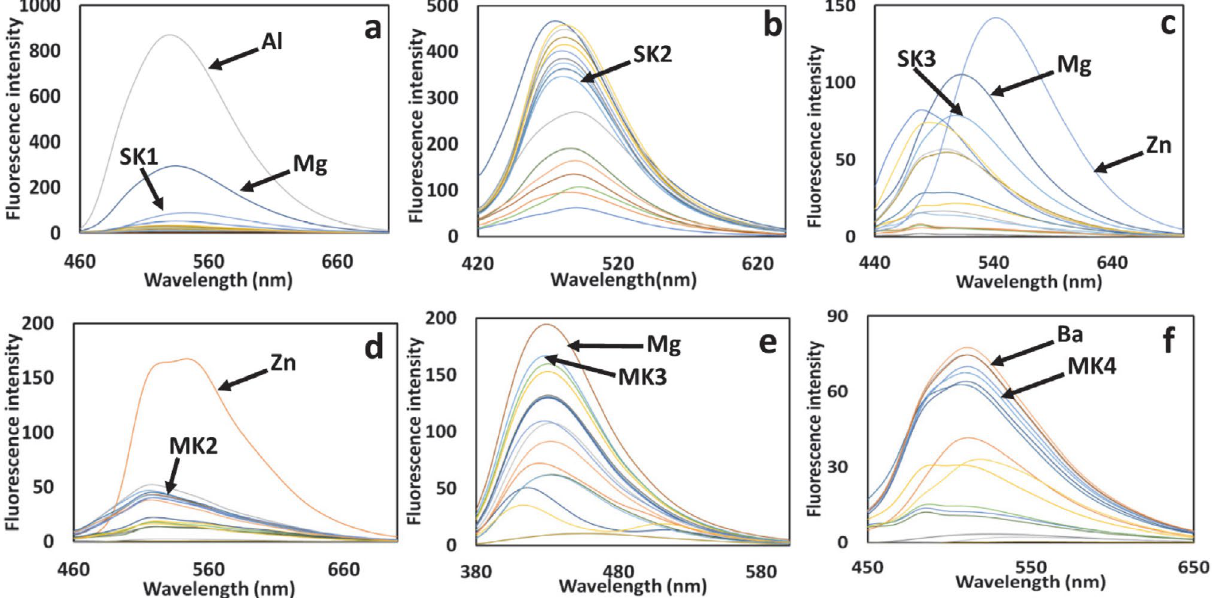
Fig. 2. Fluorescent emission spectra of (1µM); (a) SK-1 , (b) SK-2 , (c) SK-3 , (d) MK-2 , (e) MK-3 , and (f) MK-4 in the presence of several metal ions such as Li + , Na + , Ag + , Ca 2+ , Ba 2+ , Co 2+ , Cs + , Cu 2+ , Mg 2+ , Hg 2+ , Mn 2+ , Pb 2+ , Ni 2+ , Sr 2+ , Zn 2+ and Al 3+ (10 eq. for each metal